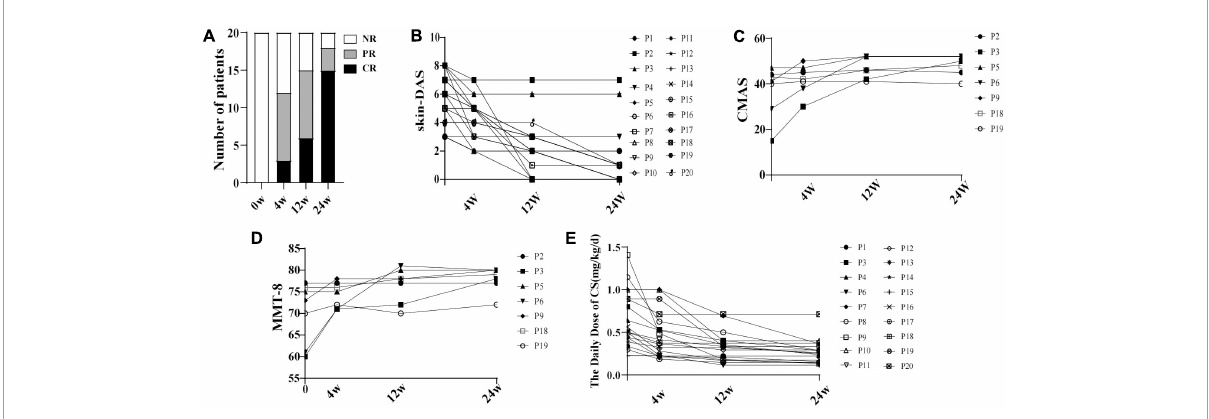
FIGURE1 The disease activity changing in 20 patients with JDM with baricitinib treatment. (A) Proportion of the 20 patients with JDM achieving CR and/or PR within 24 weeks at different follow-up times with baricitinib treatment. (B) Decrease of skin-DAS of 20 patients. (C) Increase of CMAS of 7 patients. (D) Increase of MMT of 7 patients. (E) Decrease of the daily dose of CS. NR, non-response; CR, complete response; PR, partial response; DAS, disease activity score; p, patient; CMAS, childhood myositis assessment